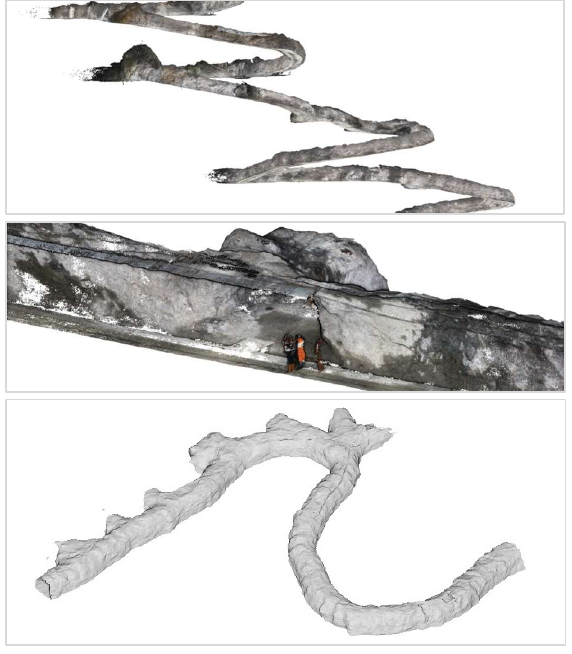
Figure 4 . portions of the point cloud (top and centre) and mesh model (bottom) of the IMI Fabi